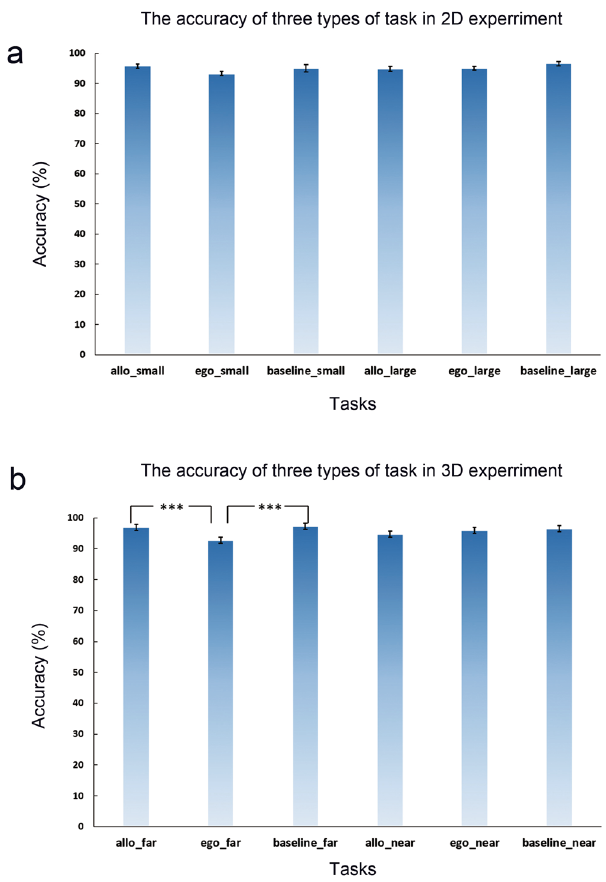
Figure 4. The accuracy of three types of task in 2D and 3D experiment. ( a ) The accuracy of three types of task in 2D experiment. ( b ) The accuracy of three types of task in 3D